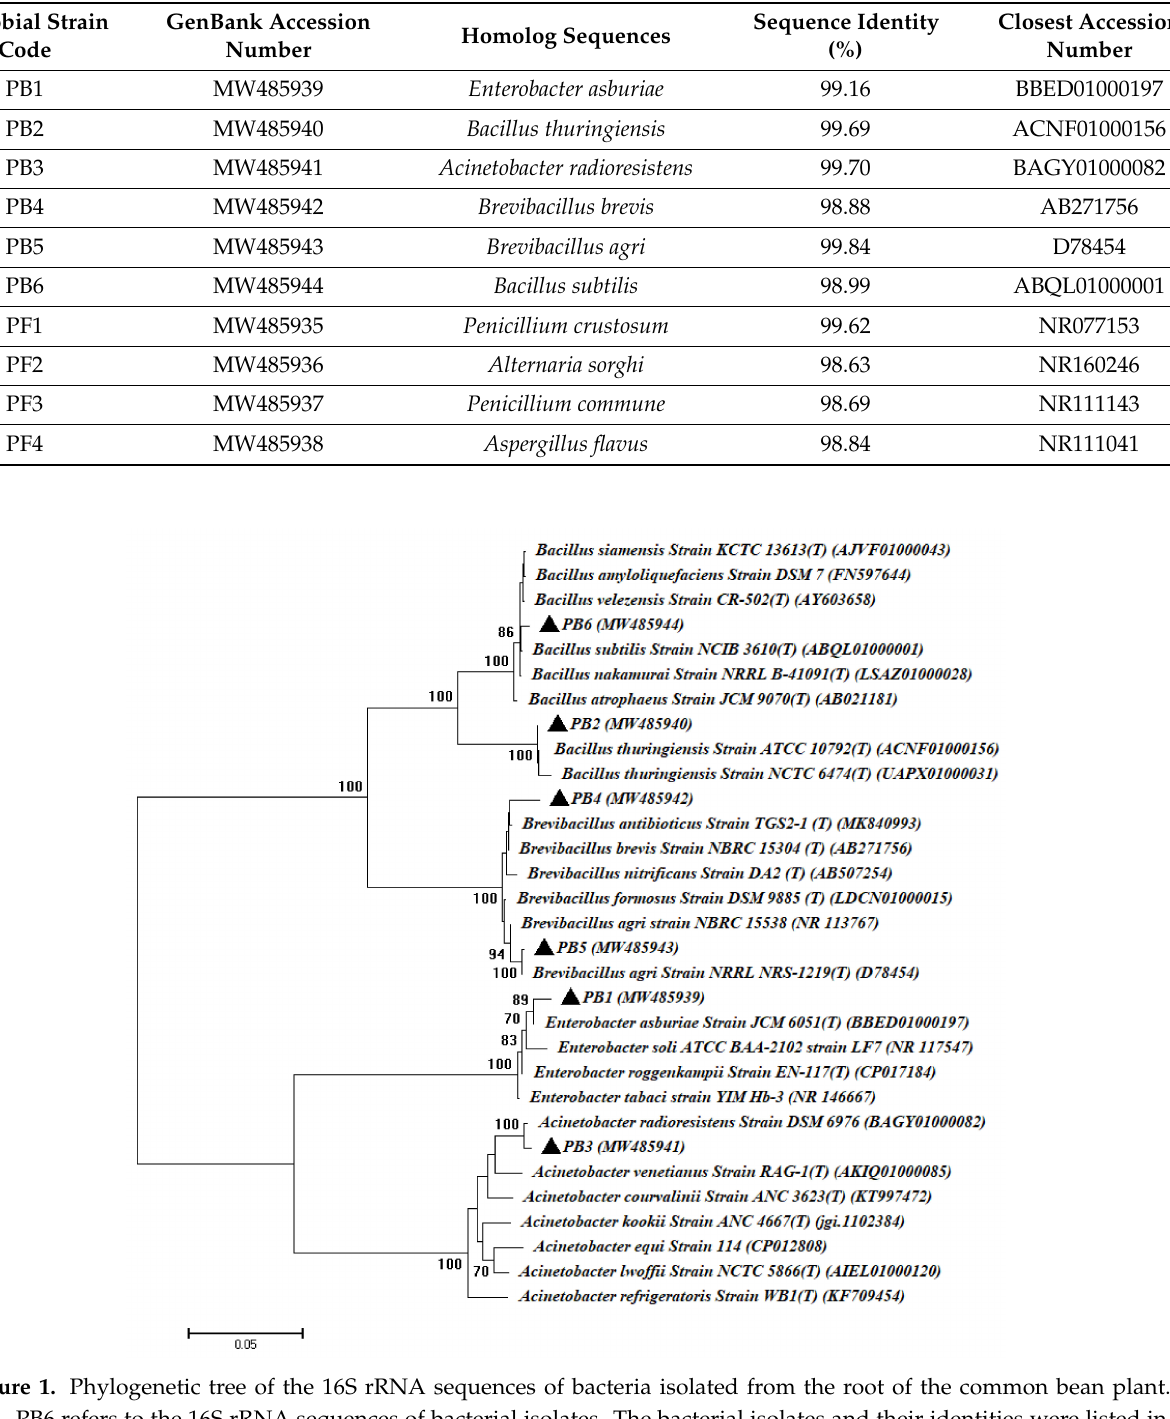
Table 1. The 16S rRNA and ITS sequence identifications of the bacterial and fungal endophytes isolated from sterilized root of common bean plants.